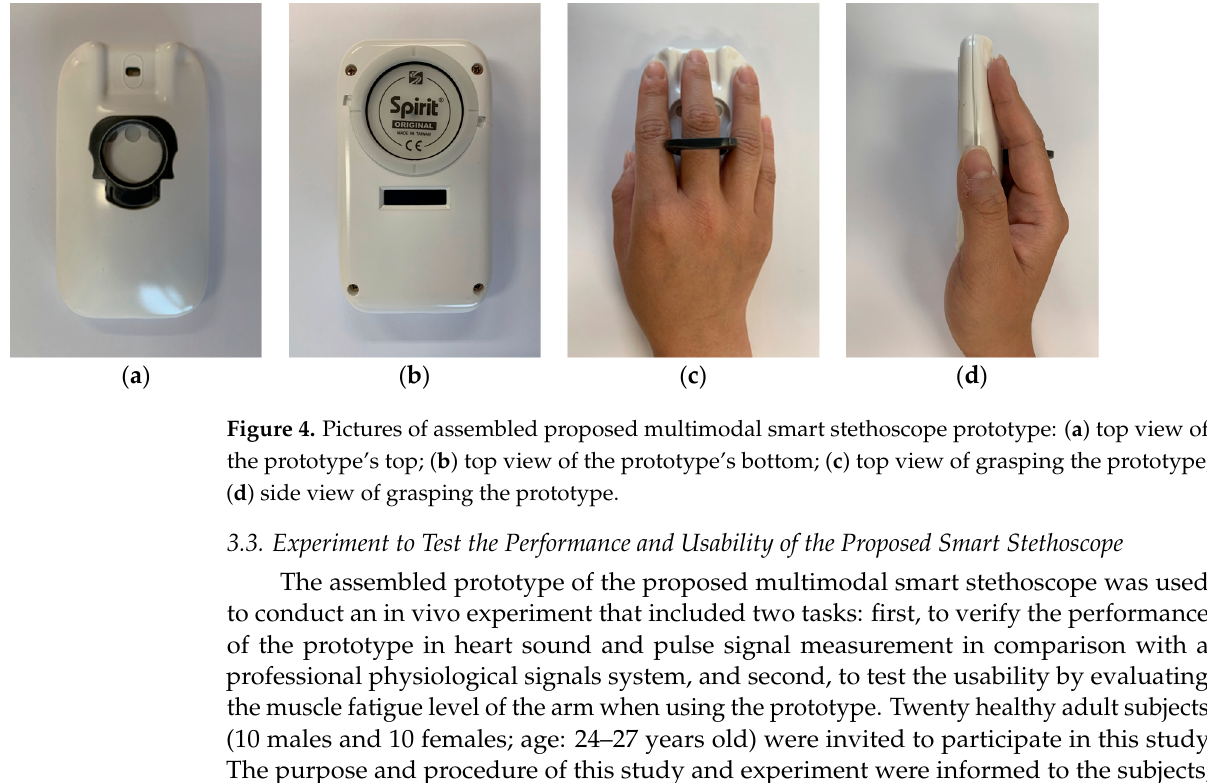
Figure 3. Structure of the proposed multimodal smart stethoscope in 3D.